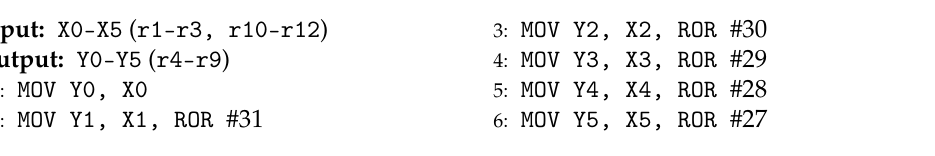
Algorithm 3 Bit-slicing implementations of ShiftColumns in ARMv6